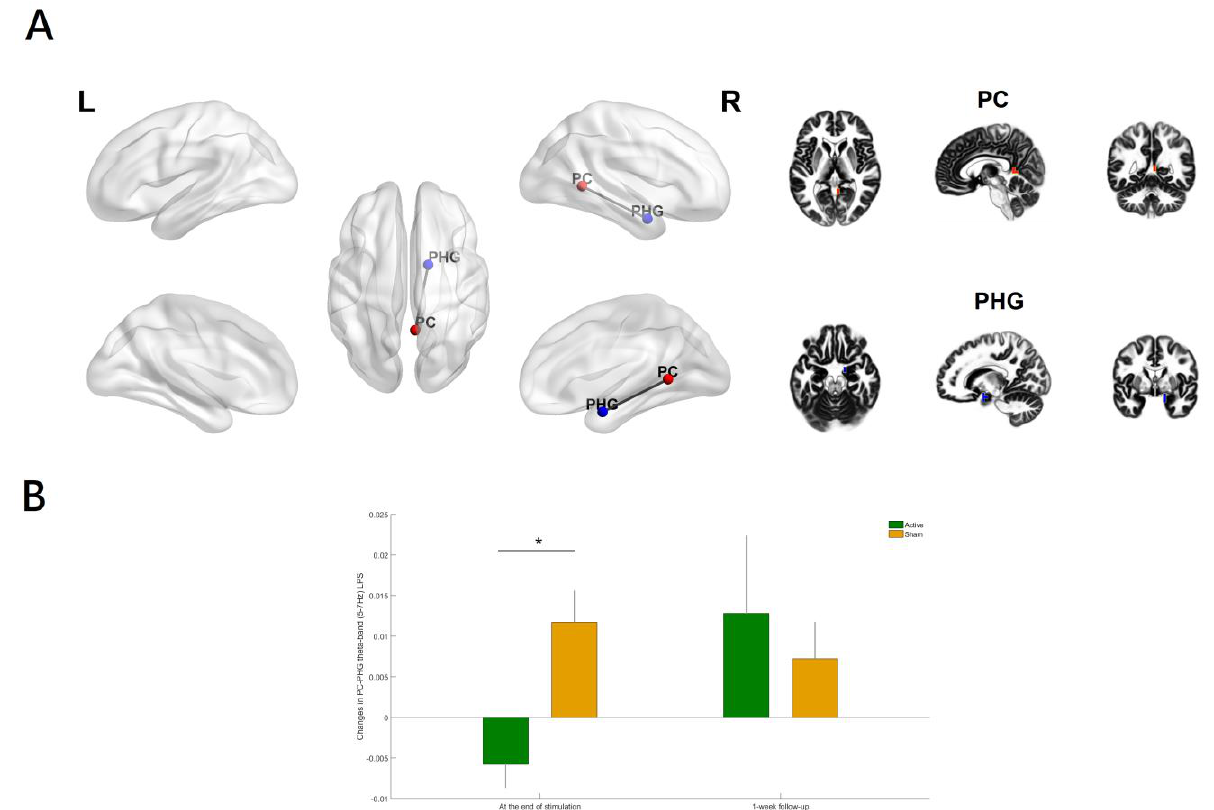
Figure 4. ( A ) Relative to the sham group, the theta-tACS group had a significant decrease in theta- band (5–7 Hz) lagged phase synchronization (LPS) between the posterior cingulate (PC) and the parahippocampal gyrus (PHG) only ( B ) from baseline to the end of stimulation ( p value = 0.0009, corrected). Color coding: PC (right hemisphere), red; PHG (right hemisphere), blue. The figure was created using eLORETA and BrainNet Viewer. Regions of interest (ROIs) shown here are displayed on a 5 × 5 × 5 MNI template brain in eLORETA for analyses (5 mm resolution is used). Error bars indicated standard errors. * p < 0.05 (corrected).